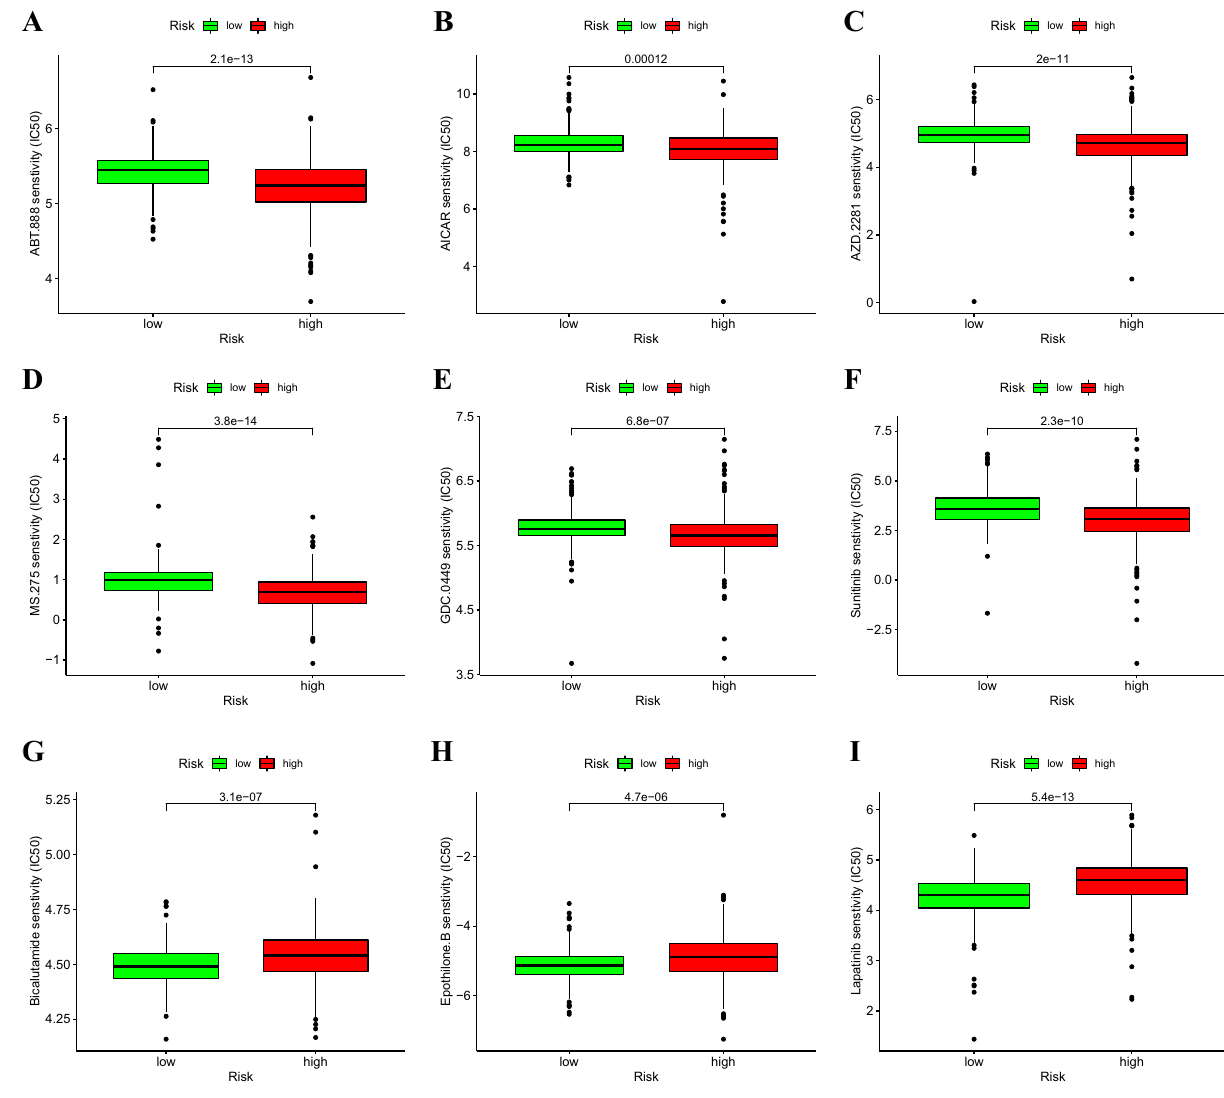
Figure 8. Comparison of drug sensitivity between high-risk and low-risk groups. The half-maximal inhibitory concentrations